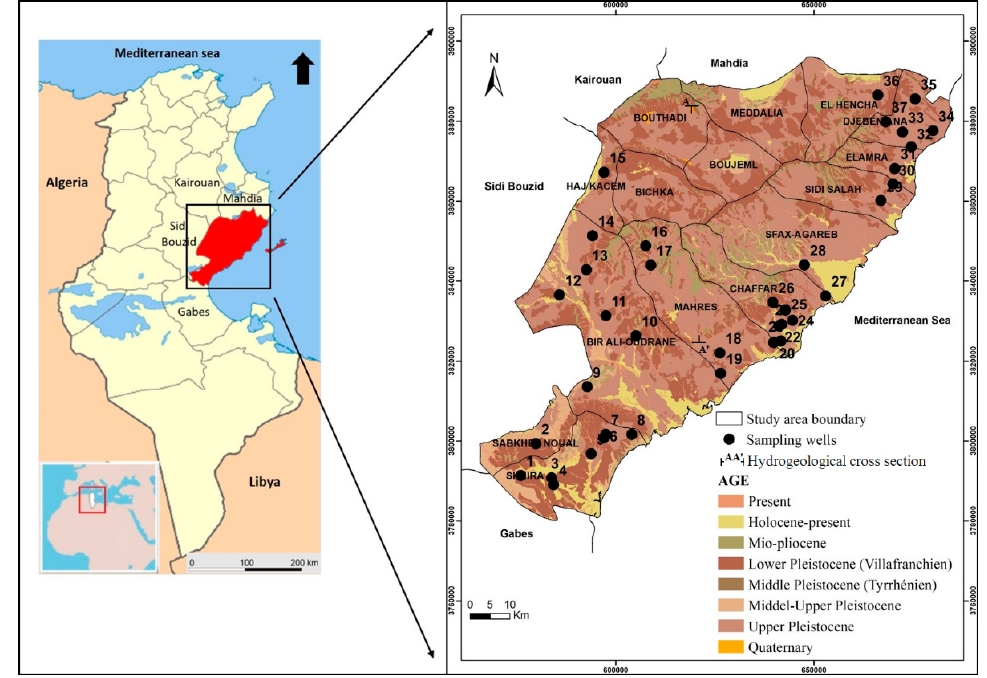
Figure 1. Geological map of the study area.